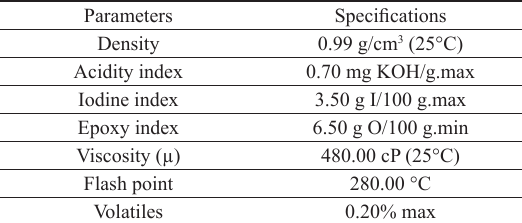
Table 2. Physicochemical properties of epoxidized soybean oil (ESO) 23 . Parameters